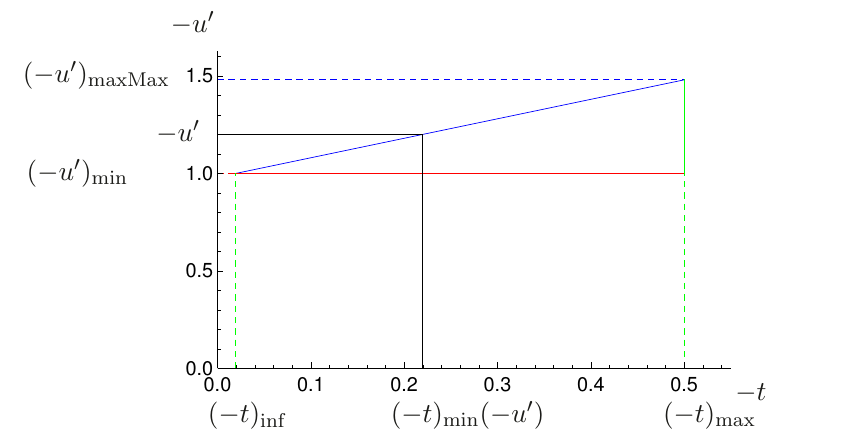
Figure 10 . Evolution of the phase space for M 2 center), M 2 = 3 GeV 2 (up right), M 2 γπ M 2 = 9 GeV 2 (down right). γπ